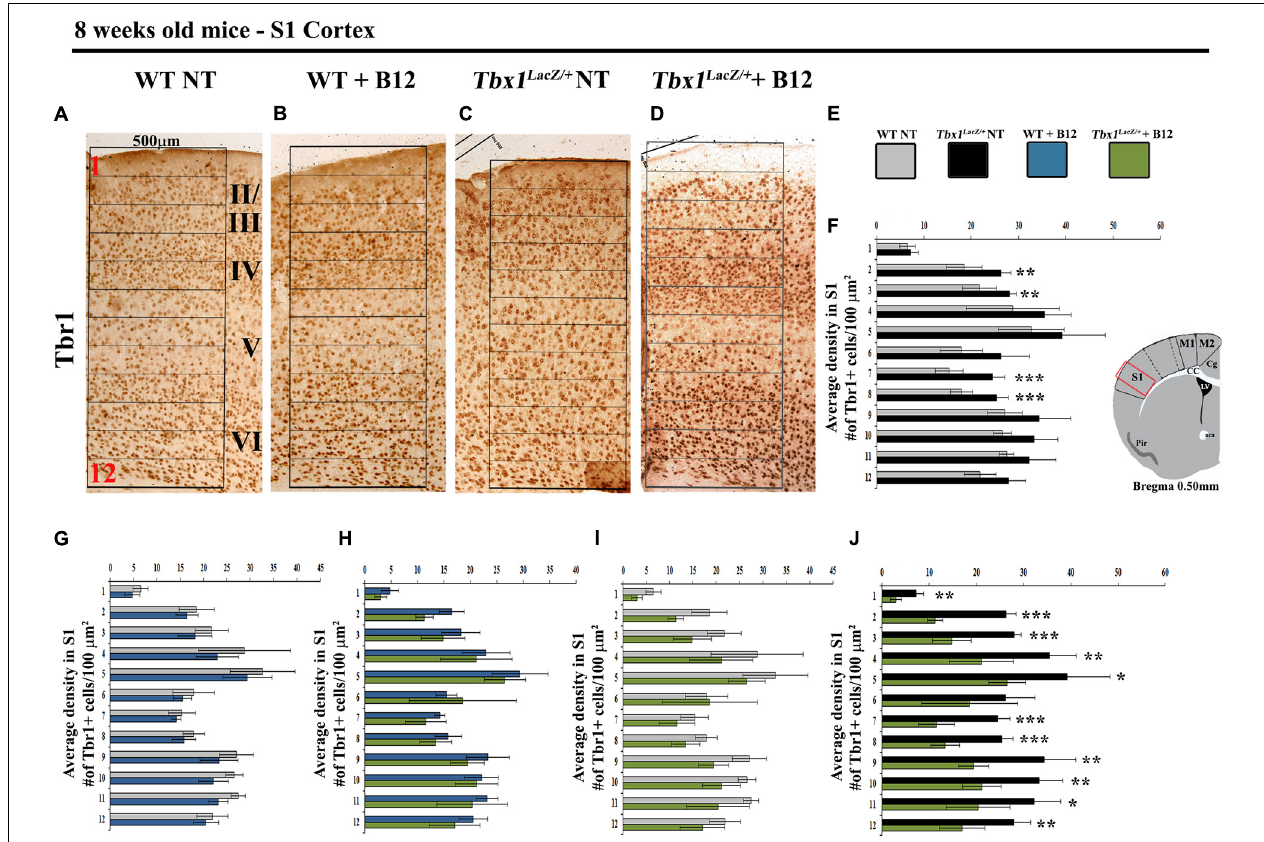
FIGURE 4 | Vitamin B12 treatment restores normal distribution of TBR1-expressing cells in the adult S1 cortex in Tbx1 heterozygous mice. (A–D) Coronal brain sections of the somatosensory (S1) cortex of young adult mice (8 weeks of age) immunostained for TBR1. Enhanced frequency of TBR1+ cells in the granular and infragranular layers (bins 2, 3, 7 and 8) in the Tbx1 lacZ / + brain (C) compared to untreated (NT) wild type (A) mice ( F , χ 2 = 26.55, df = 11, P ≤ 0.01), is rescued by B12 treatment (D) ( I , χ 2 = 18.375, df = 11, 0.10, P < 0.25). Roman numerals indicate the cortical layers I–VI, Arabic numerals indicate the position of the 12 bins used for quantification. (E) Color scheme for the genotypes shown in the histograms (F–J) . (F–J) Pairwise comparisons of the average distribution of TBR1-expressing cells in the 12 bins spanning the S1 cortex of mice with the genotypes indicated in (E) , n = 5 per genotype. The cartoon in F indicates the position of the S1 cortex (boxed area) in coronal brain sections of adult mice, at Bregma level 0.50 mm, where all measurements were made. * P ≤ 0.05, ** P ≤ 0.01, *** P ≤ 0.001, error bars indicate mean ± SD. P -values in (F,I) have been corrected by the Benjamini Hochberg